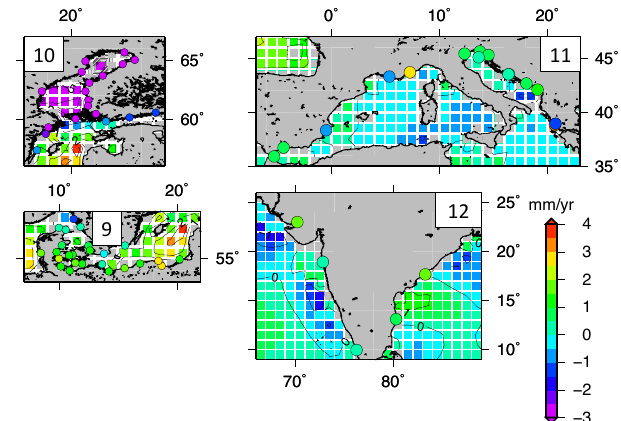
Figure 7. Trends in sea-level change (mmyr − 1 ) over the period 1961–2003, for regions (9) Baltic South, (10) Baltic North, (11) Mediterranean, and (12) India. Zoom of Fig. 4. Regions indicated in Fig.